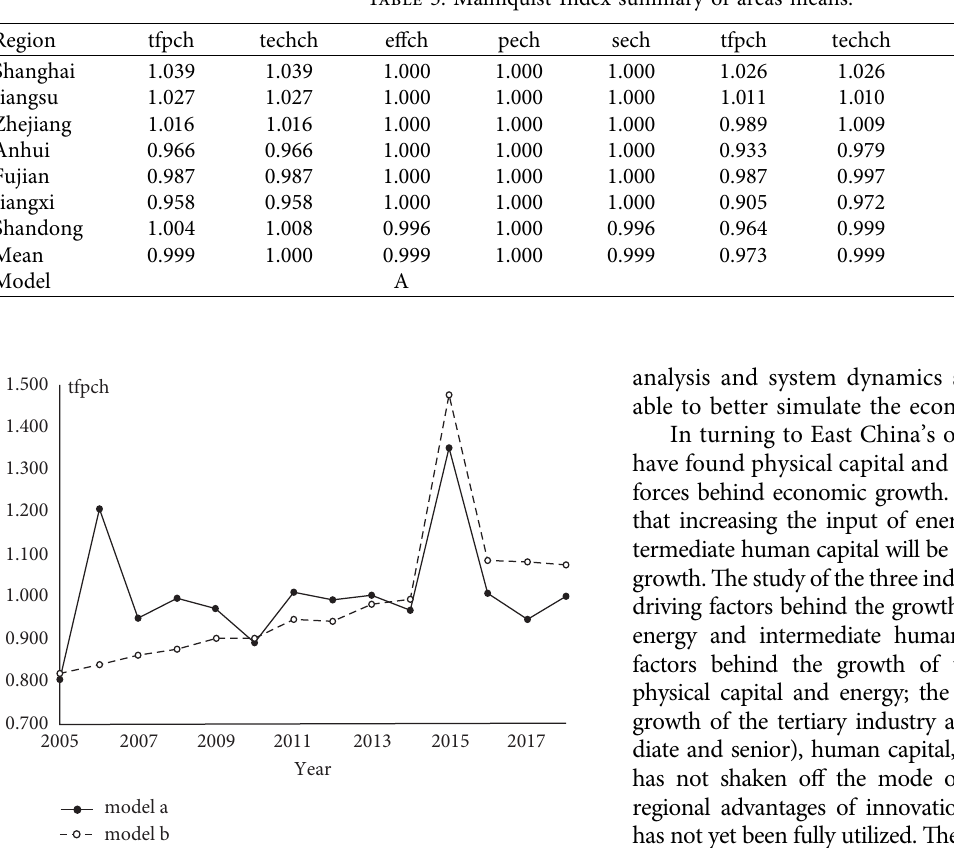
Table 5: Malmquist Index summary of areas means.